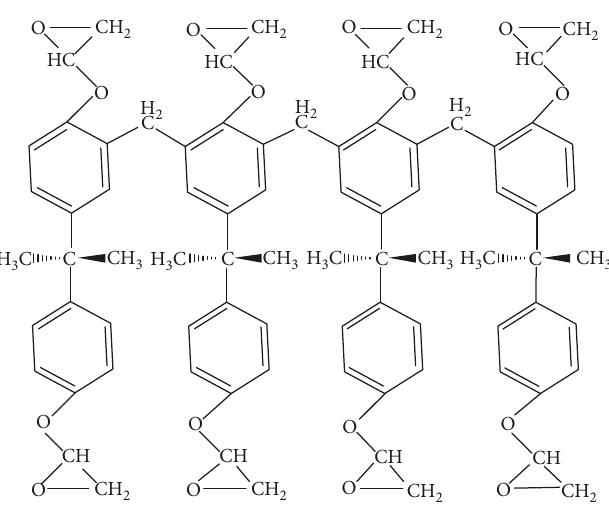
Figure 5: Structural formula of SU8, consisting only of the organic